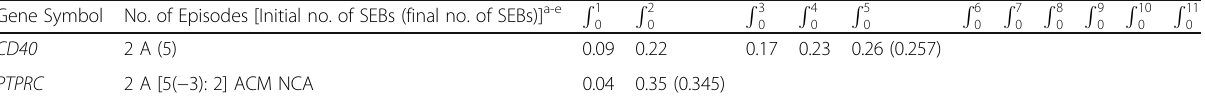
Table 6 Chromosome 20 (+) strand chromatin B-cell polarization receptor gene, CD40 , and chromosome 1 (+) strand chromatin B-cell polarization receptor gene, PTPRC, sequential esebssiwaagoT Q s to final 2-digit (and 3-digit) esebssiwaagoT Q Gene Symbol No. of Episodes [Initial no. of SEBs (final no. of SEBs)] a-e